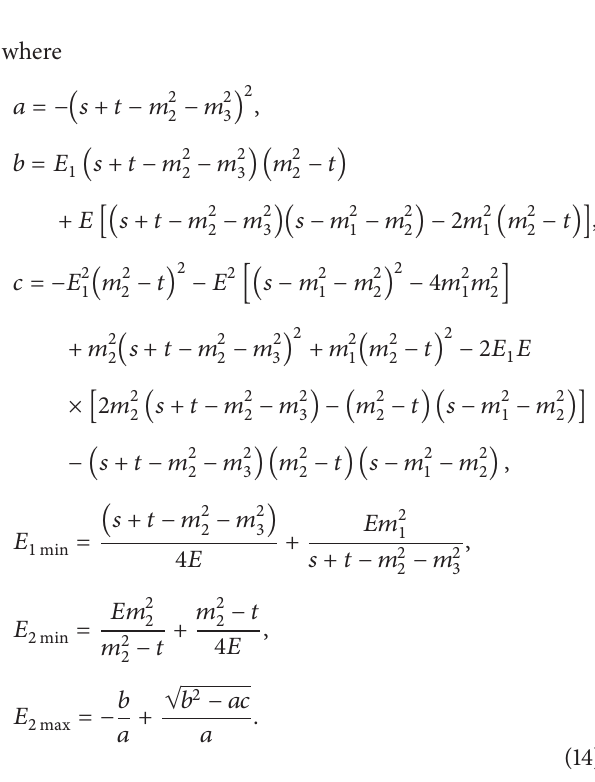
Figure 3: Optical Theorem in Quantum Field